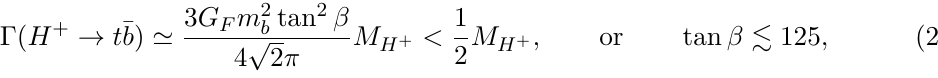
Figure 5 . Predicted top quark width Γ t as a function of M Democratic 3HDM, for θ = − π/ 4 and various values of tan β . In the upper panel M tan γ = 4 , and δ = 0 . 85 π . The lower left panel has the same values of M M = 500 GeV. In the lower right panel M H + 3 allowed range of top quark widths from refs. [28, 29] lies in shaded red